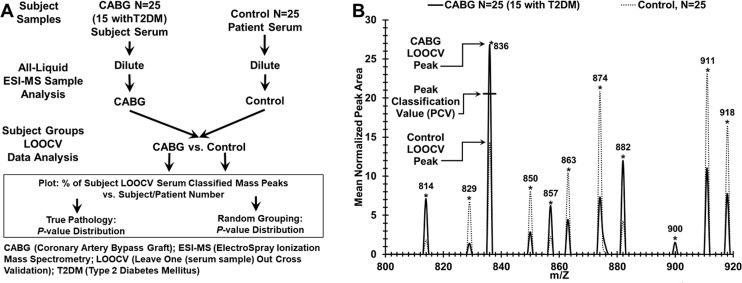
Experimental approach for discriminating sera from patients with CAD before undergoing CABG procedure versus sera from control individuals.(A) Flow chart for serum sample handling and mass spectrometry for binary patient/subject group analysis. Distinguishing control samples from CABG samples are exhibited. (B) Peak Scoring for LOOCV (leave [one serum sample] out cross validation) procedure to classify mass peaks either “CABG” or control from a “left out” sample, over a narrow range (800–920 m/Z is displayed) of significant group discriminatory mass peaks. The PCV (peak classification value) example is exhibited on peak 836 which is used to classify “left out” peaks as either CABG (solid line, peak area above this PCV) or control (dotted line, peak area at or below this PCV).